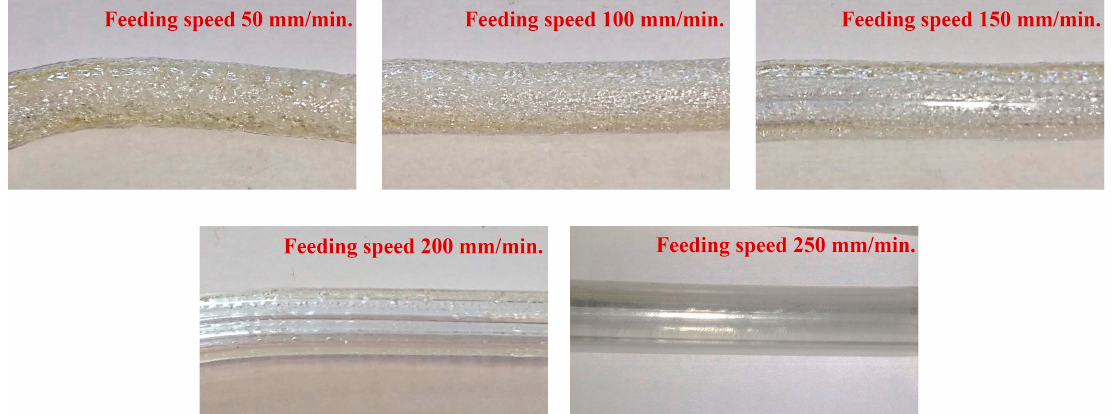
Figure 7. ( a ) Structured nozzle design. From left to right: a 3D model, cross-section of a side- and a bottom-view. Blue arrows represent the direction of polymer flow in the structured 3D printer’s nozzle. ( b – d ) Micromachined structured nozzle: ( b ) structured body, ( c ) body + cover, ( d ) after suspended-core (SC)-MPOF drawing [59].